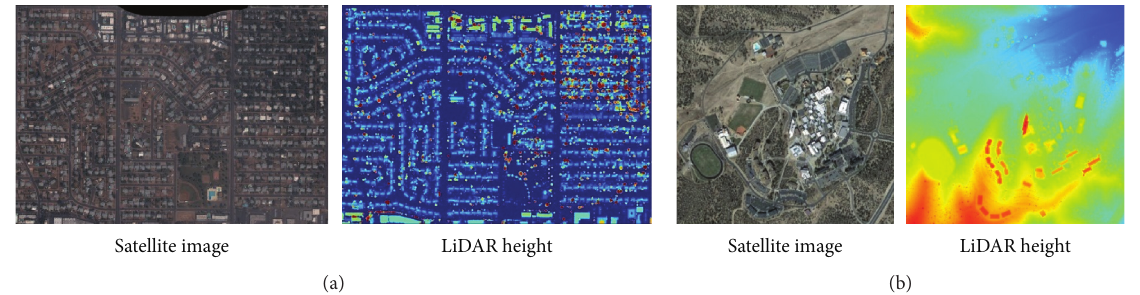
Figure 4: Visual illustration on (a) experimental dataset 1 and (b) experimental dataset